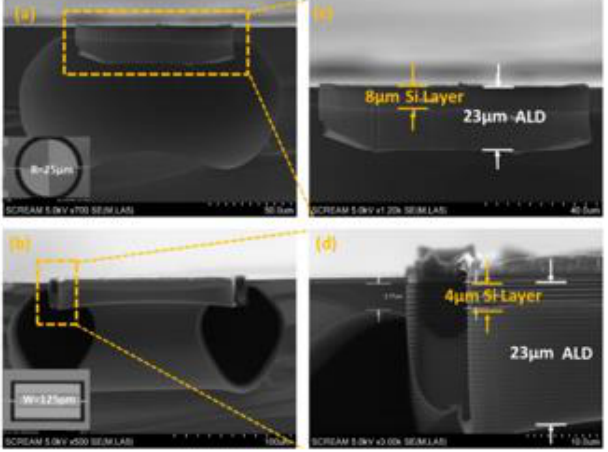
Figure 1. SEM view of TPoSCRE fabricated TPoS RF MEMS resonator devices.